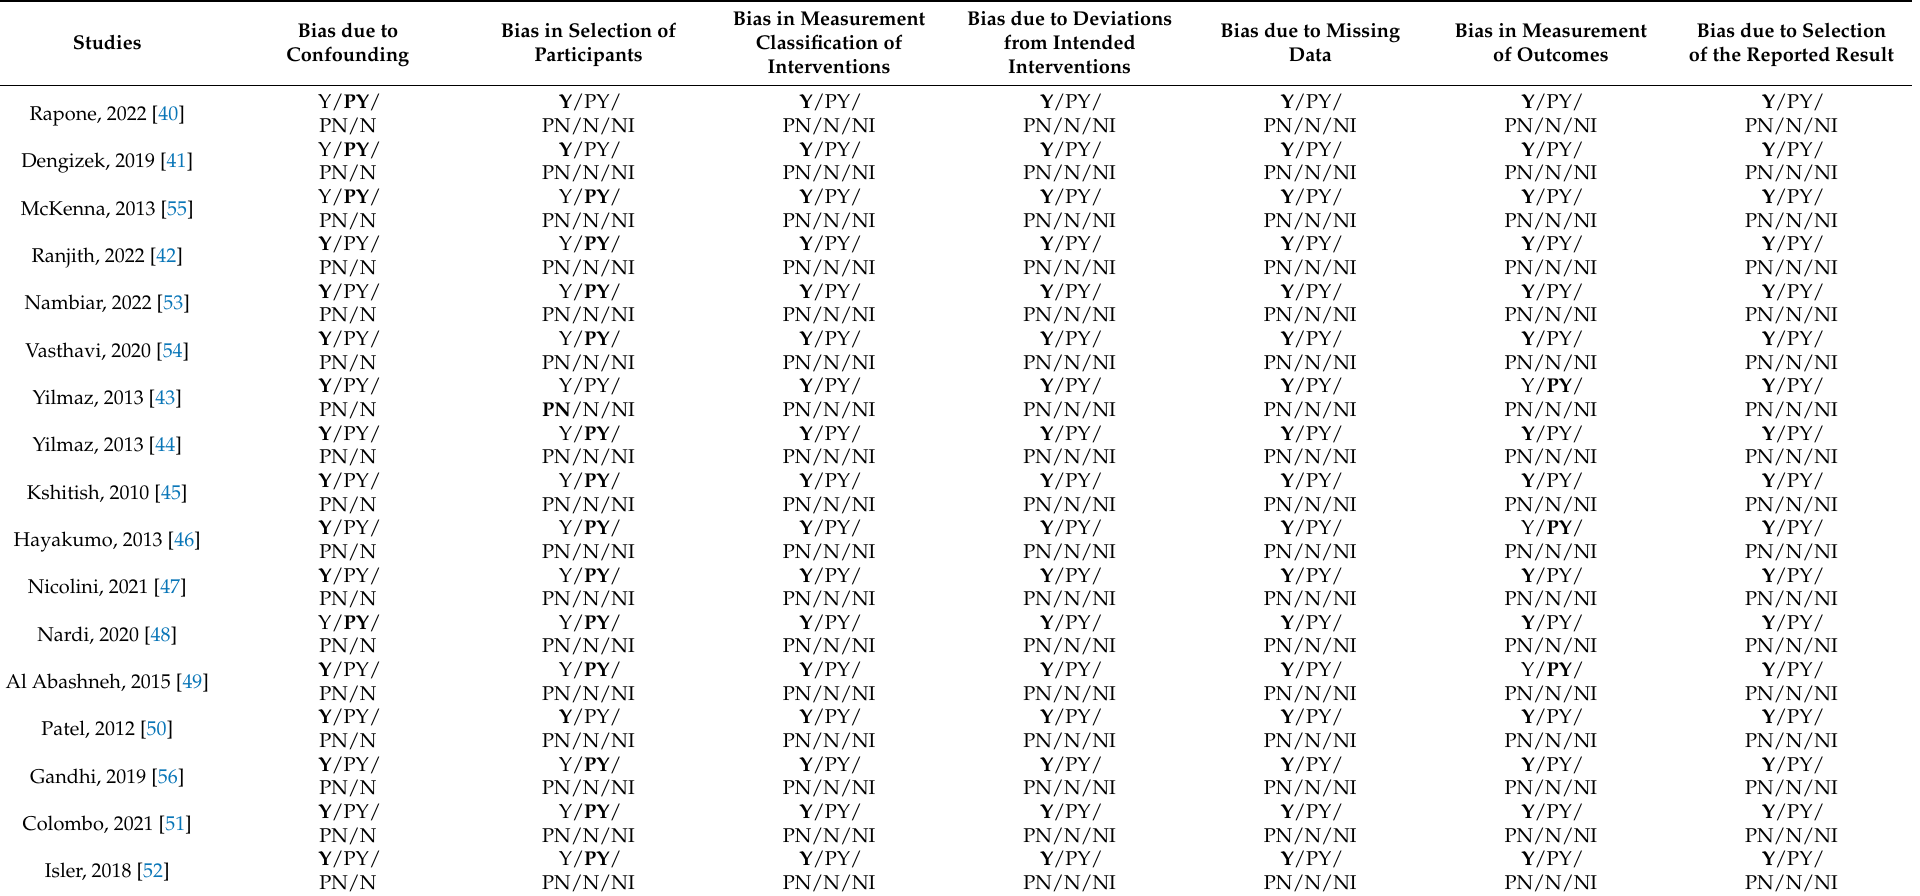
Table 7. Risk of bias in the studies included in the systematic review. The response options regarding biases included Yes (Y), Probably yes (PY), Probably no (PN), No (N) and No information (NI). “Y” indicated a low risk of bias, “PY” indicated a moderate risk of bias, “PN” indicated a serious risk of bias, “N” indicated a critical risk of bias and NI indicated that was no information related to